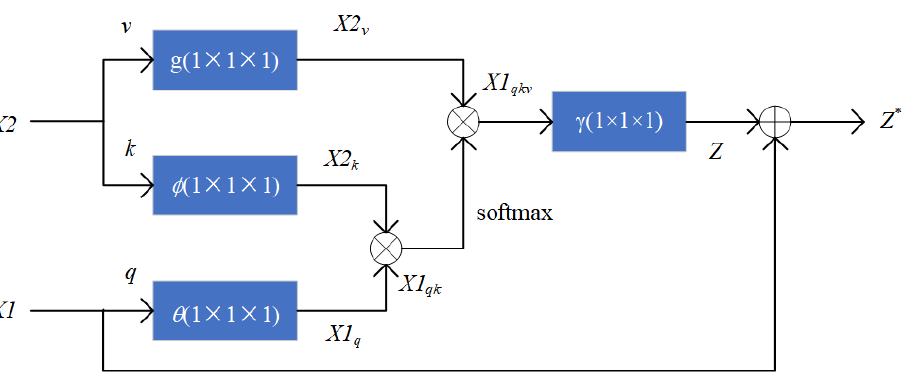
Figure 4. Non-Local Network.